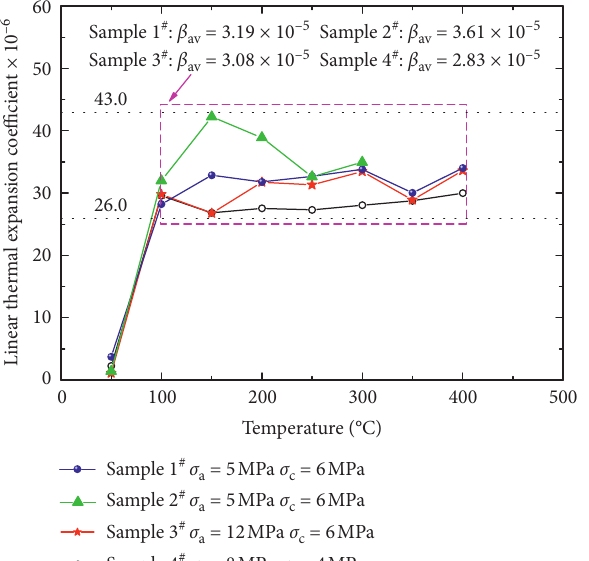
Figure 5: Linear thermal expansion coefficient of mudstone at high temperature and triaxial